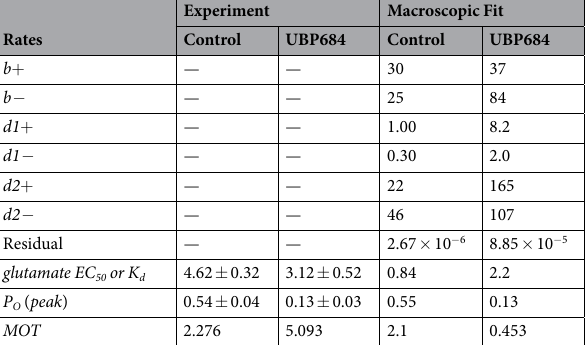
Table 3. Fitting of macroscopic GluN1/GluN2A current response and effect of UBP684. The normalized residual sum of squares (indicated as Residual) were derived from the macroscopic fitting with the gating rates fixed to those derived from MIL fits (Fig. 4); the desensitization ( d ) and agonist binding ( b + ) and unbinding ( b − ) rates were set as free parameters. The agonist binding rates are in µ M − 1 s − 1 and all other rate constants are s − 1 . The K d is in µ M and calculated as b − / b + . The desensitization rates were constrained to 5-fold ± rates derived from MIL fits (Fig. 4). Open probability ( P o ), mean open time